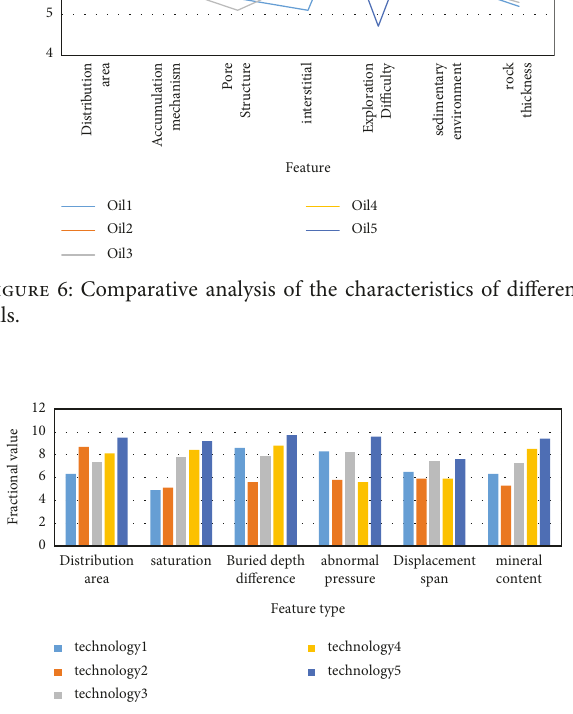
Figure 7: Exploration efforts of tight oil reservoir characteristics by different